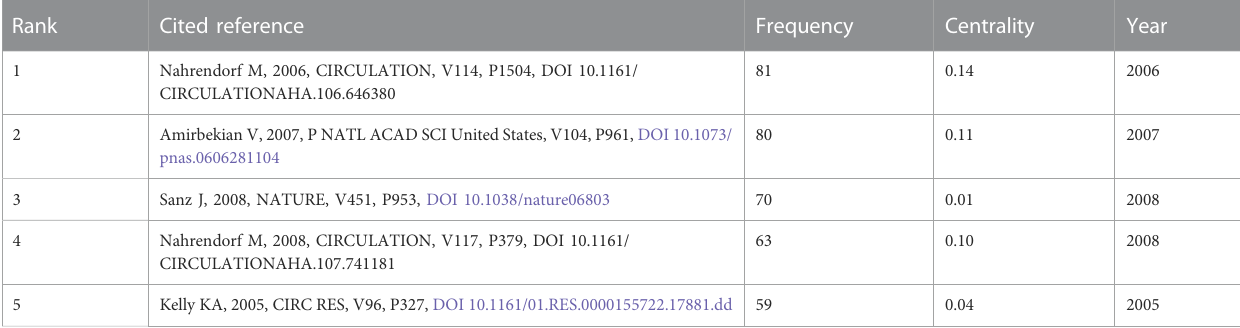
TABLE 6 Top fi ve co-citation papers of molecular imaging research in AS in terms of